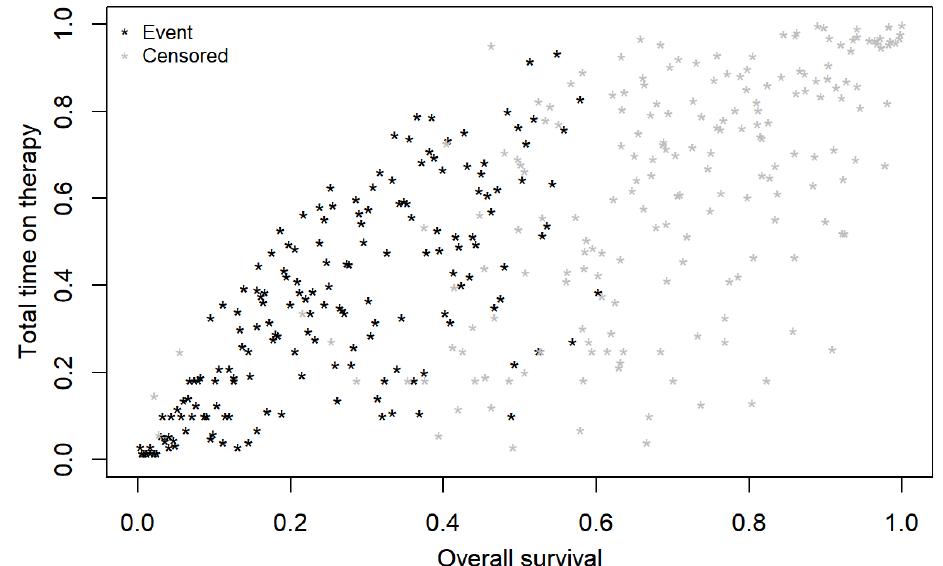
Figure 2. Bivariate copula plot depicting correlation between real-world overall survival (rwOS) and real-world time to next treatment (rwToT) of patients with advanced melanoma treated with first-line pembrolizumab.